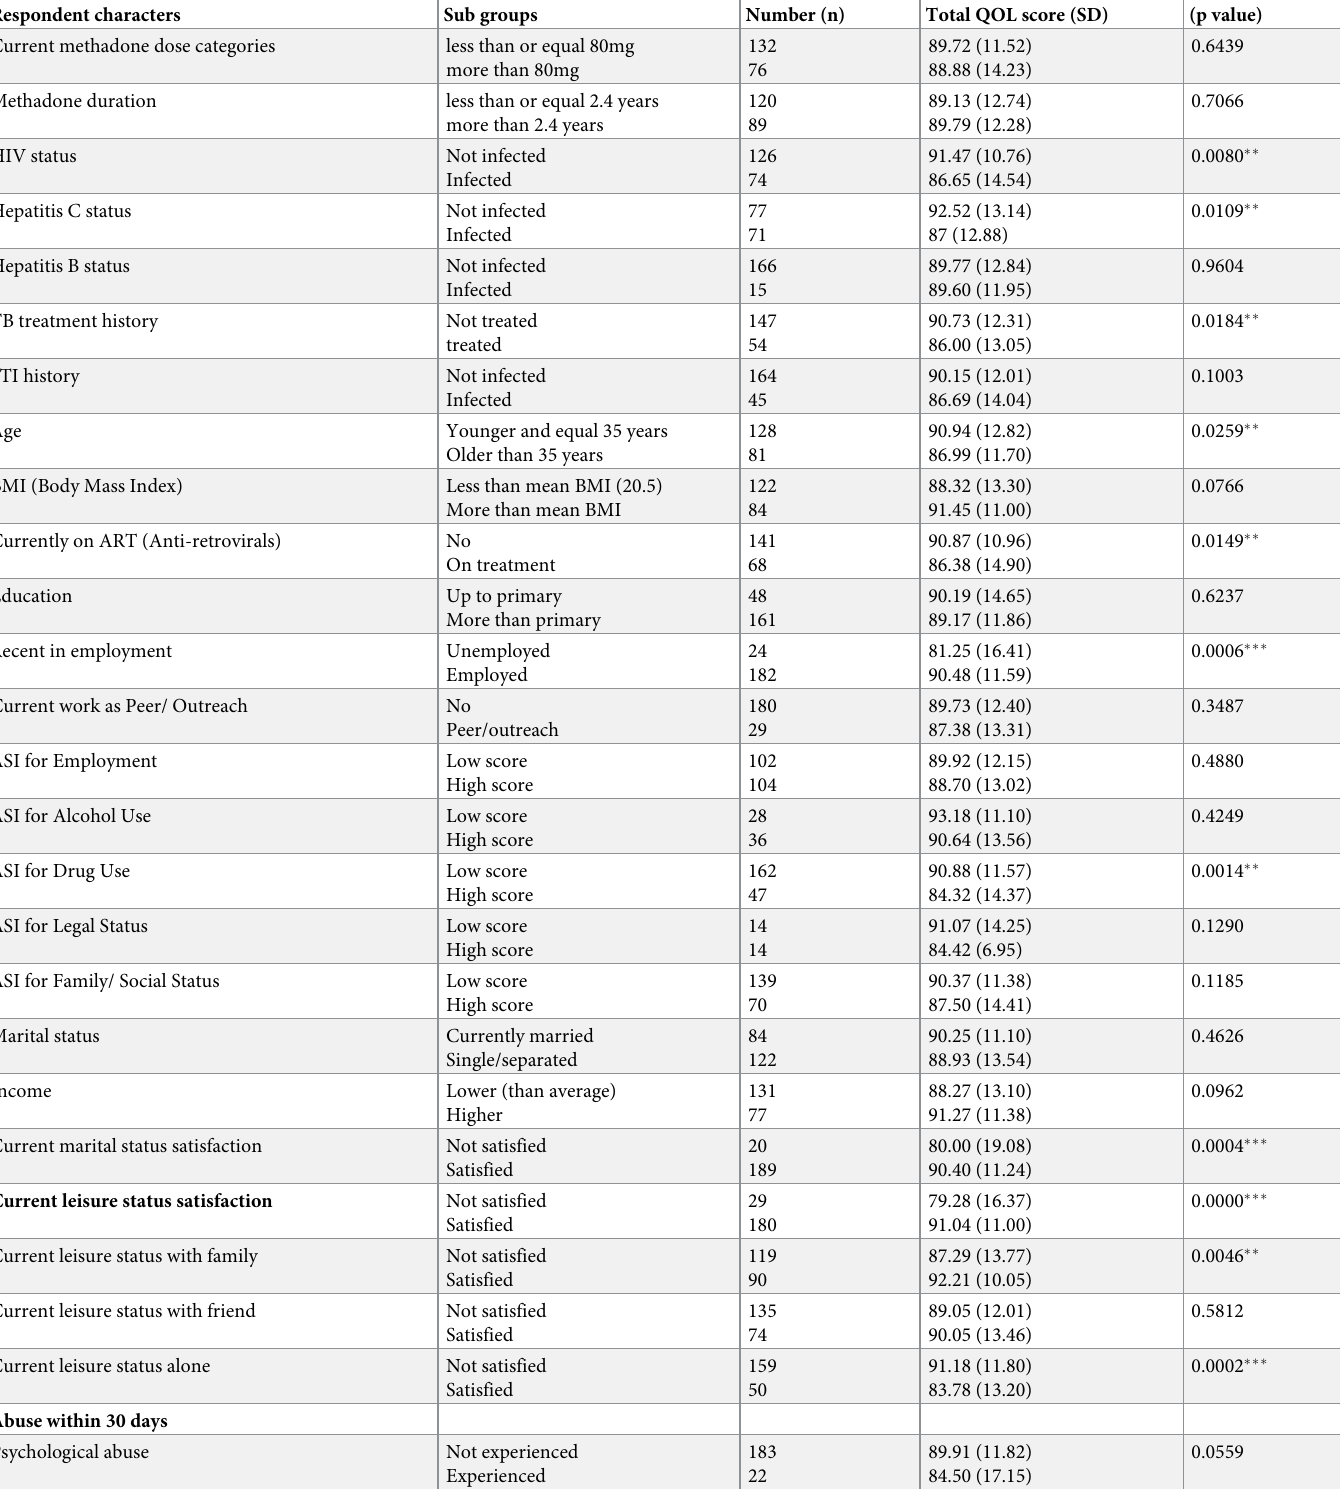
Table 2. Table showing the quality of life (QOL) total score differences by the respondents’